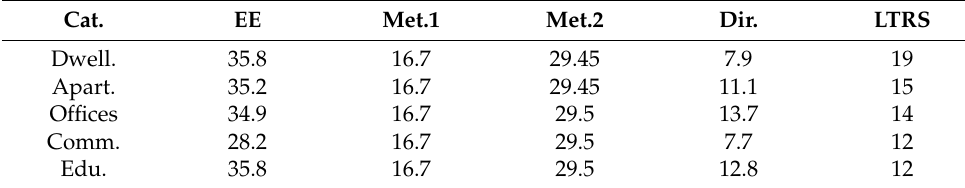
Table 13. Energy consumption reduction in 2033 vs. 2020, TWh/a. Cat. EE Met.1 Met.2 Dir. 15% Dwell. 0.09 0.07 0.145 0.068 Apart. 0.47 Offices